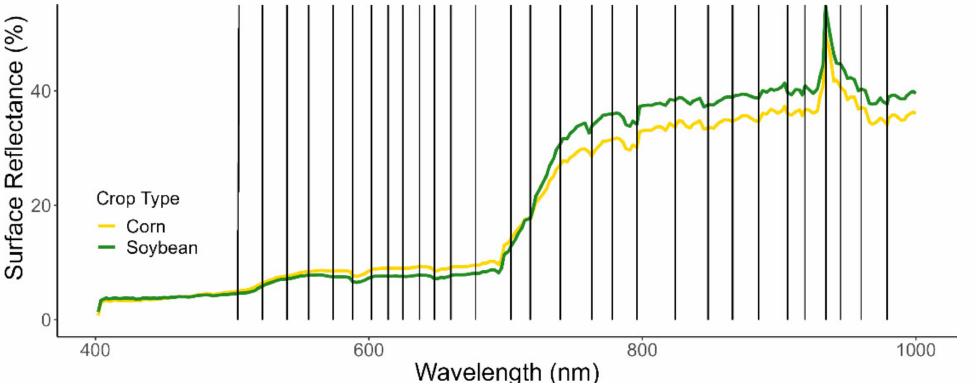
Figure 2. DESIS optimal bands. The twenty-nine optimal DESIS bands shown with example spectral profiles for corn and